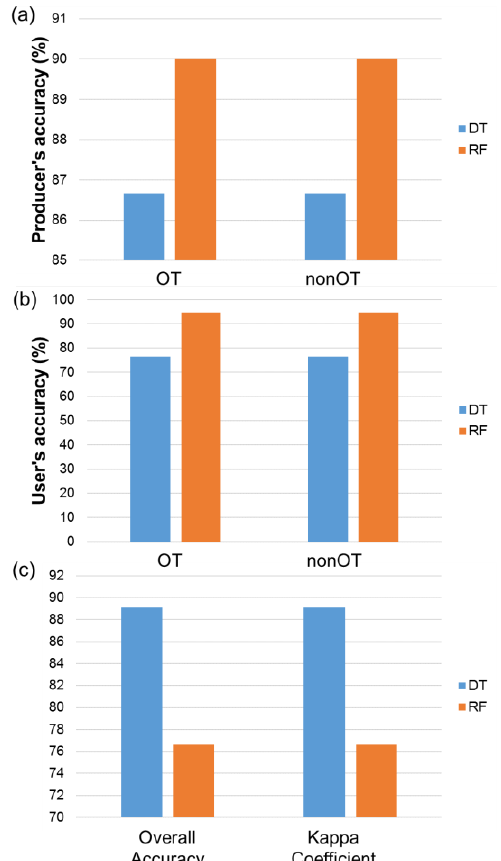
Figure 1. Evaluation results including (a) producer’s accuracy, (b) user’s accuracy, and (c) overall accuracy and kappa coefficient with test datasets for decision trees and random forest.